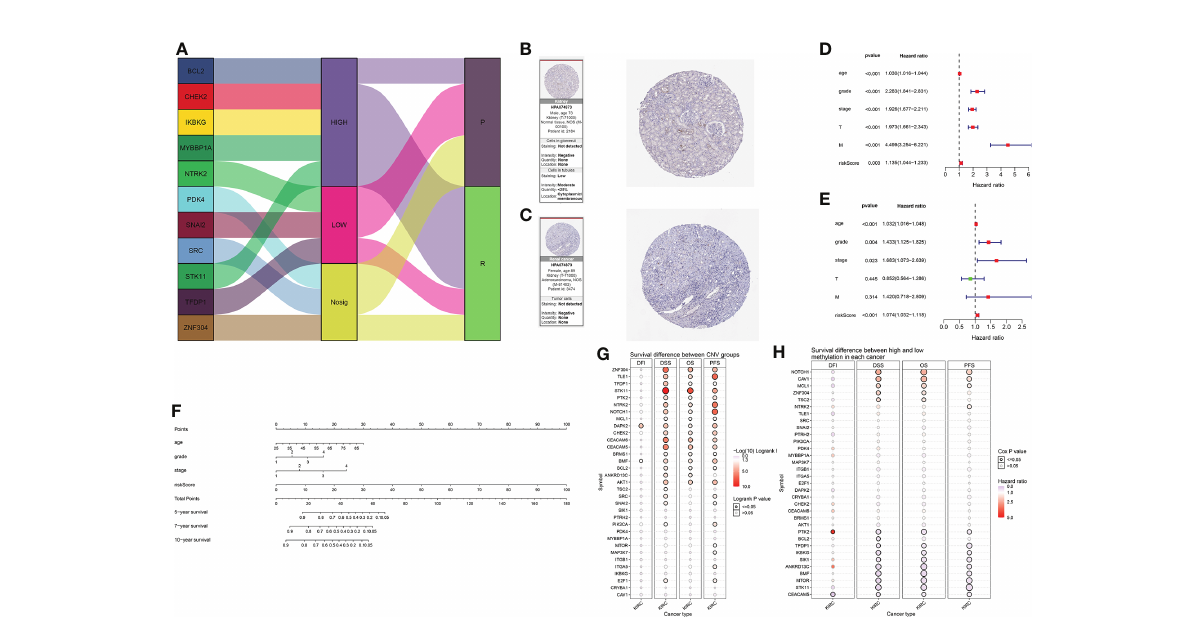
FIGURE 7 (A) Sankey diagrams used to summarize the data on the eleven selected genes, including their expressionand prognosis. (B, C) The association between anoikis-related genes and KIRC was con fi rmed at the protein level. Immunohistochemical images of protein NTRK2 was obtained from the HPA website. (D) Forest plot of univariate Cox analysis. (E) Forest plot of multivariate Coxanalysis. (F) Nomogram of the prediction model. The total score is calculated using ABC, fromwhich 5-, 7-, and 10-year survival rates can be obtained. (G) Correlation between CNV mutations of different anoikis-related genes and survival coef fi cient in KIRC. (H) Correlation between methylation of different anoikis-related genes and survival coef fi cient in